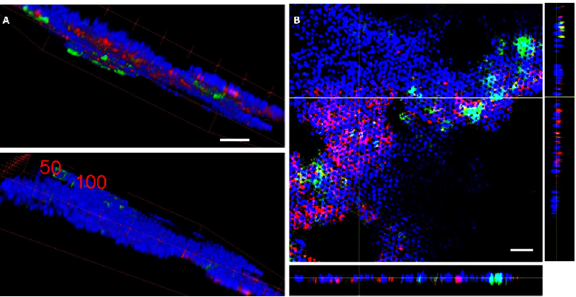
Figure 3. HT29 cells were seeded for 15 days on G0 Hex surfaces in glucose-containing medium without MTX. The cells were fixed with PFA and stained with TRITC-phalloidin for actin filaments (red), FITC-UEA for MUC2 on goblet cells (green), and DAPI for the nuclei (blue). By confocal microscopy, a z-stack was recorded and visualised in 3D volume view. ( A ) Front and back of the cell layer (see also supporting video 1). ( B ) Image on the focal plane of the cell layer in x-y, x-z, and y-z direction. Number of independent experiments: n = 2. Scale bars: 50 µ